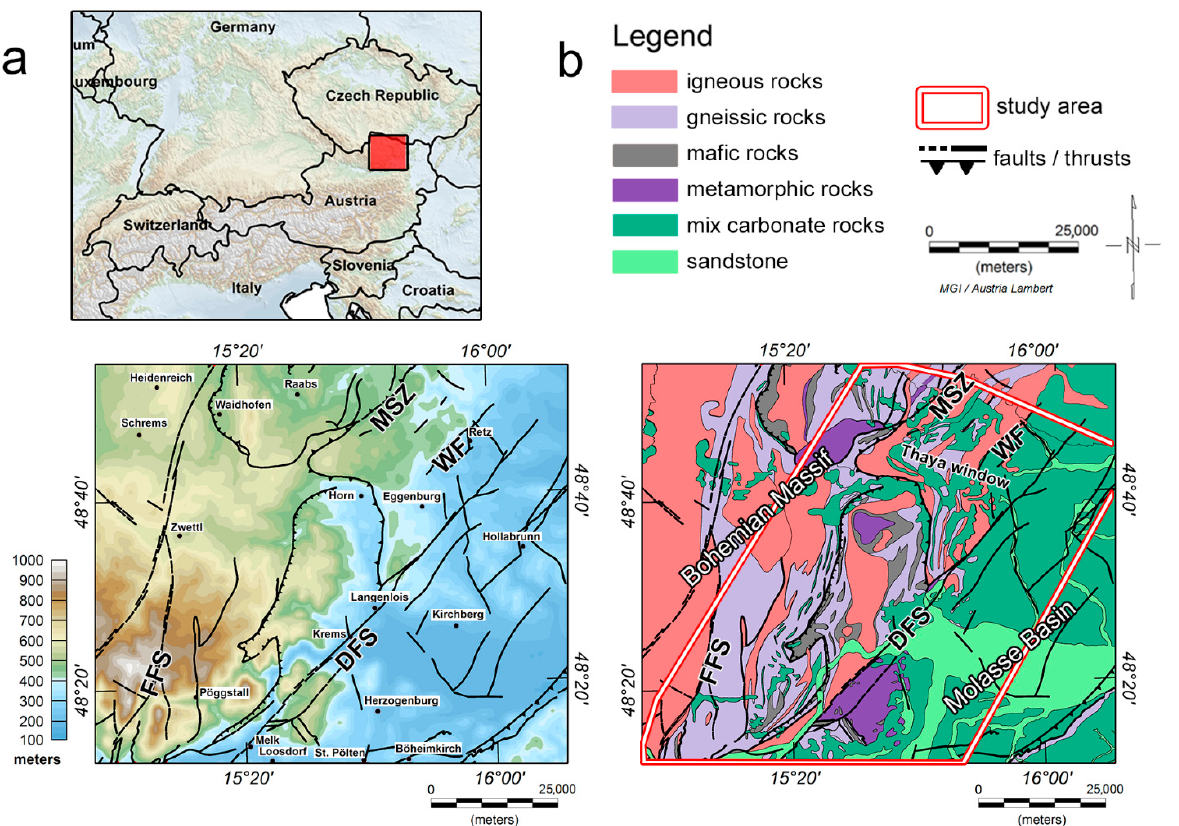
Figure 1. The study area: ( a ) DTM model (SRTM 1 arc model [21]); black lines show the main geological structures of the region, ( b ) geological sketch map (modified after [22]). MSZ: Moldanubian Shearzone; DFS: Diendorf Fault System; WF: Waitzendorf Fault; FFS: Freyenstein Fault System.